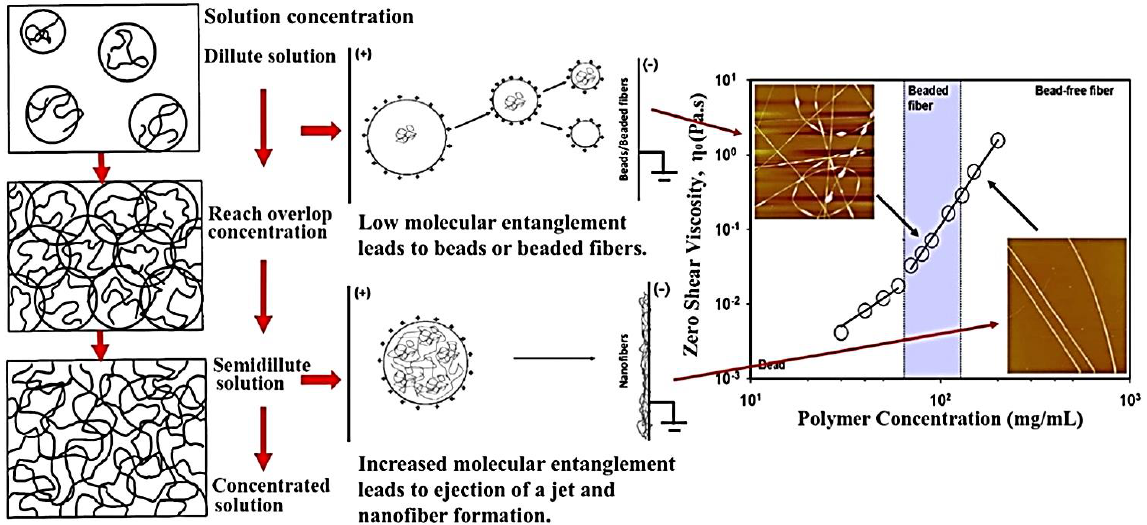
Figure 4. Effect of different polymer concentrations and their molecular entanglement have a direct influence on the morphology of the nanofibres during electrospinning. Reproduced with permission from [60], copyright 2017 Elsevier.